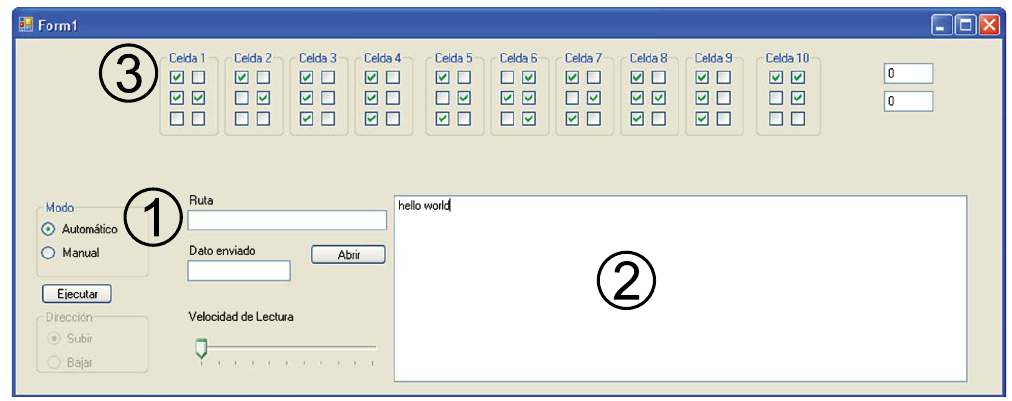
Fig. 2. Snapshot of the TactoBook Braille translator and its 3 main functions: (1) file upload, (2) textbox, and (3) manual mode.